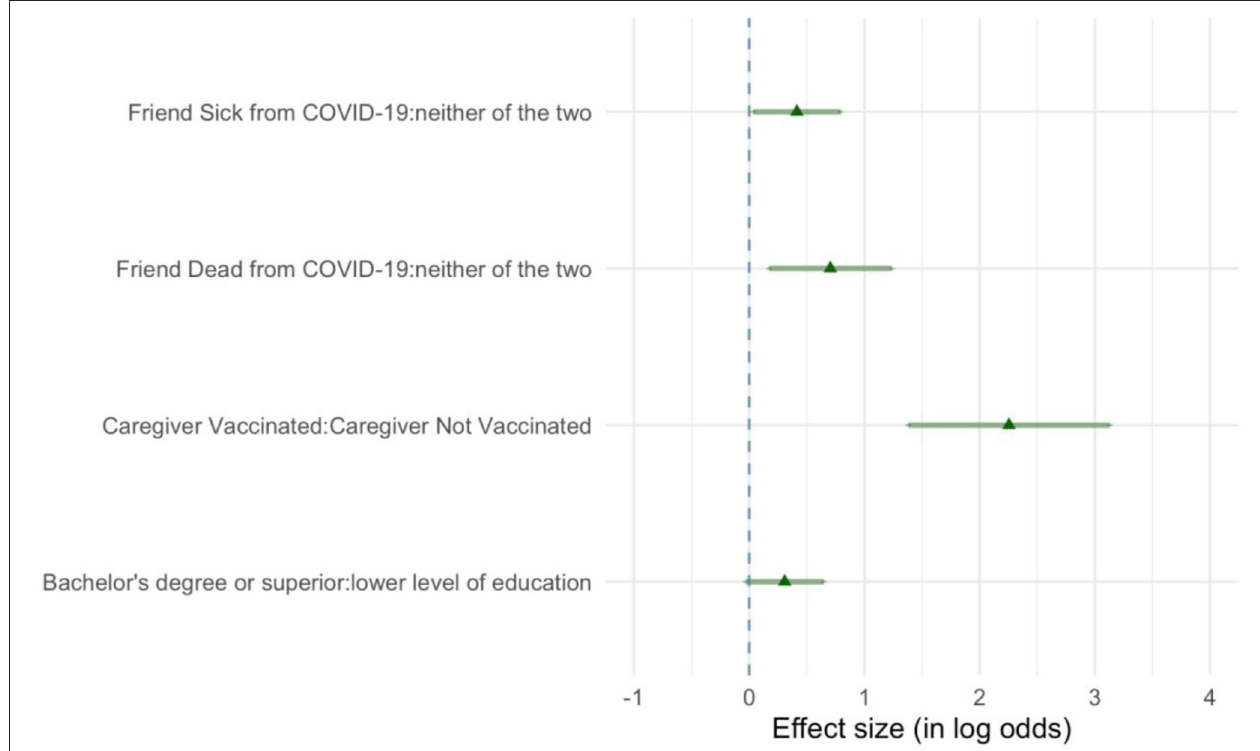
FIGURE 2 | In this forest plot, the strength of association between the different conditions and the propensity to vaccinate the child are represented by means of the logarithmic form of the odds ratios computed by modeling a logistic regression model. Here, the conditions positively associated to the propensity to vaccinate the child are represented. The greater the logarithms of the odds ratios, the stronger is the association between a given condition and the propensity to vaccinate the child. Triangles indicate the point estimation while whiskers represent the 95% confidence intervals. For the caregiver having a friend or acquaintance who got ill or died due to COVID-19, the reference level is “neither of the two” conditions; for the caregiver’s COVID-19 vaccination status, the reference level is “Caregiver Not Vaccinated”; for the caregiver’s level of education, the reference level is “lower level of education.” Reference level means that when computing the odds ratio, the condition is put at the